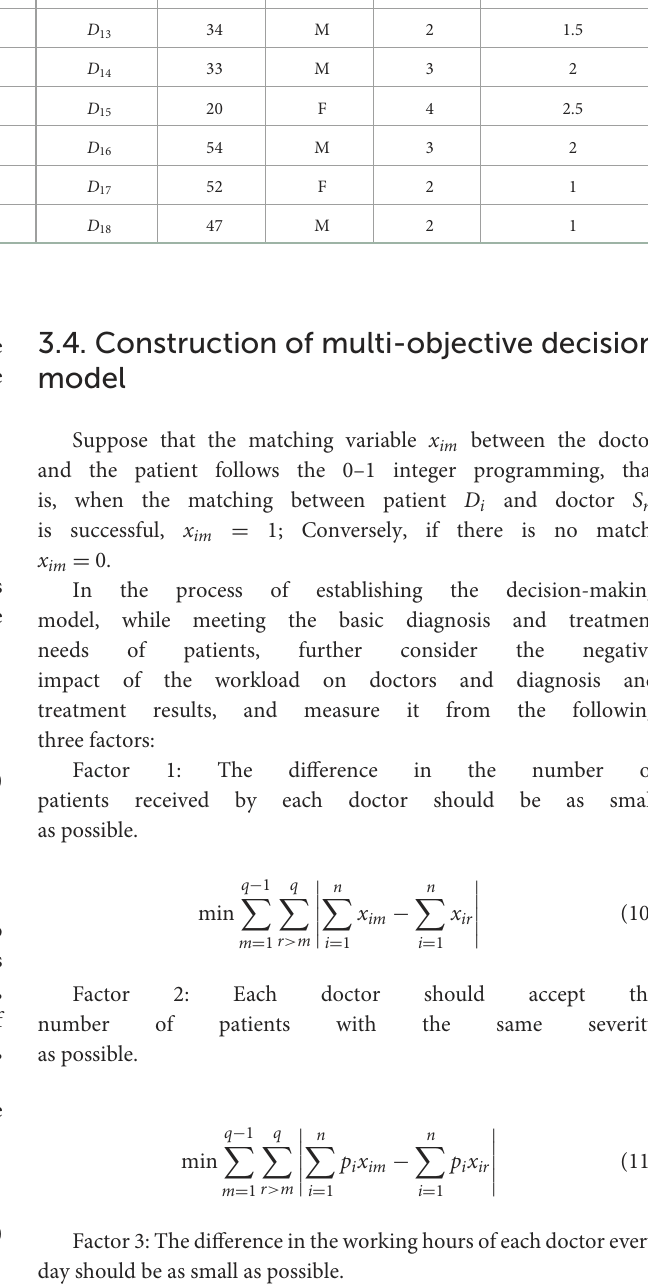
Estimated degree time of diagnosis